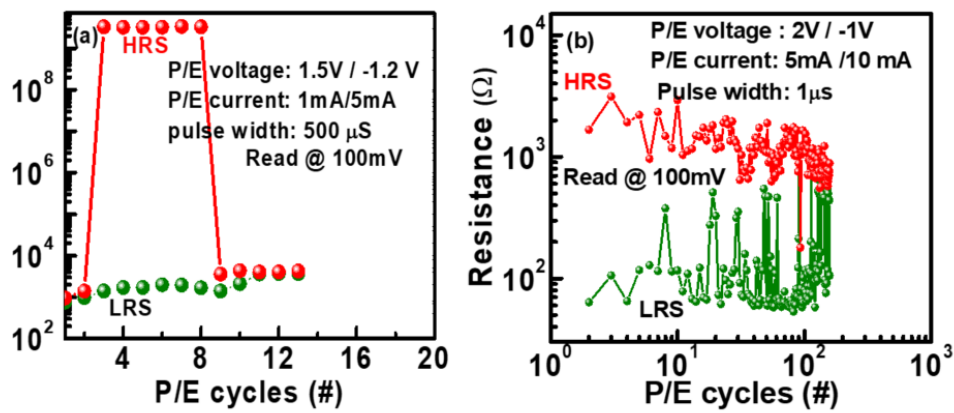
Figure 7. Typical P / E endurance characteristic of the S2 devices using ( a ) 500 µ s and ( b ) 1 µ s pulse width. Figure 7. Typical P/E endurance characteristic of the S2 devices using ( a ) 500 µs and ( b ) 1 µs pulse width. Table 1. Device performance comparison based on high on / o ff ratio with recently published results in Table 1. Device performance comparison based on high on/off ratio with recently published results in literature.